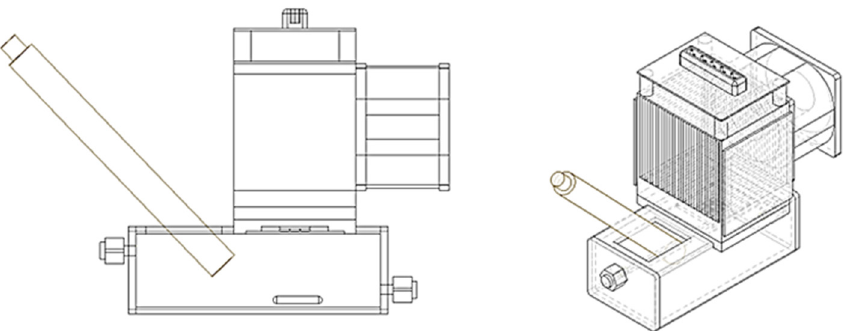
Figure 7. Sonophotocatalytic reactor concept (h × b × l = 30 × 42 × 100 mm, V = 134 mL) with tip − sonotrode (f US = 20 kHz, A = 1.3 cm 2 , P A,max = 95 W/cm 2 ) or magnetic stirrer and a UVB − LED-system ( λ = 300 nm, P UV = 52 mW/cm 2 ).